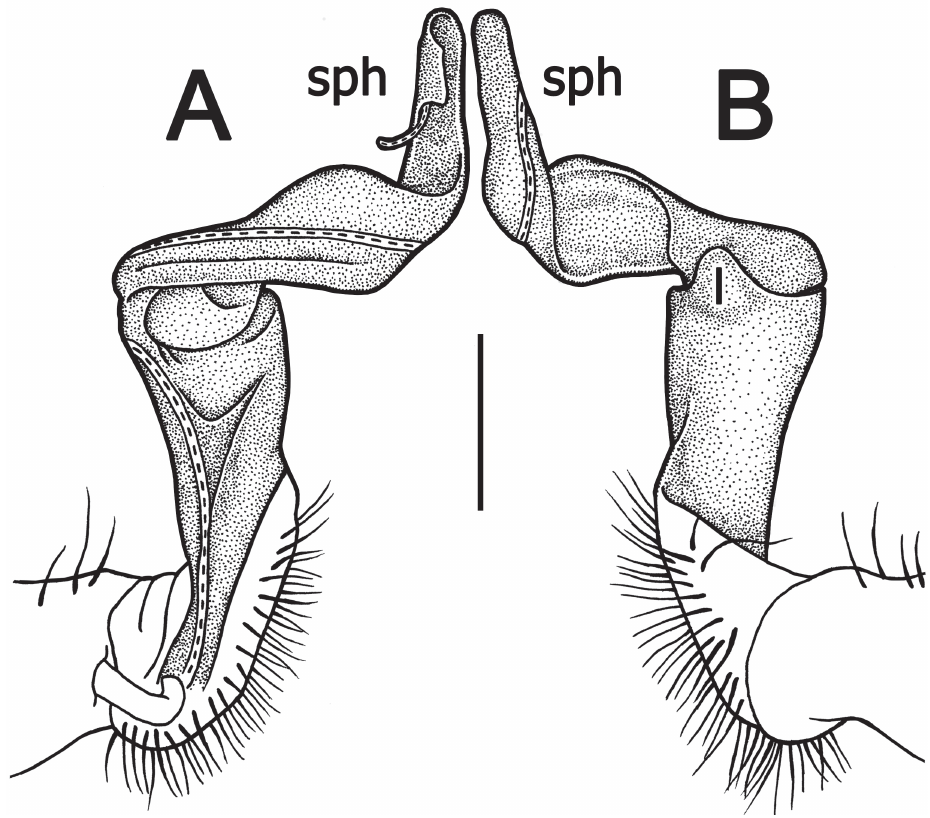
Fig. 8. Tylopus moniliformis sp. nov., paratype, ♂, left gonopod. A–B . Mesal and lateral views, respectively. Scale bar = 0.2 mm. abbreviations are explained in the